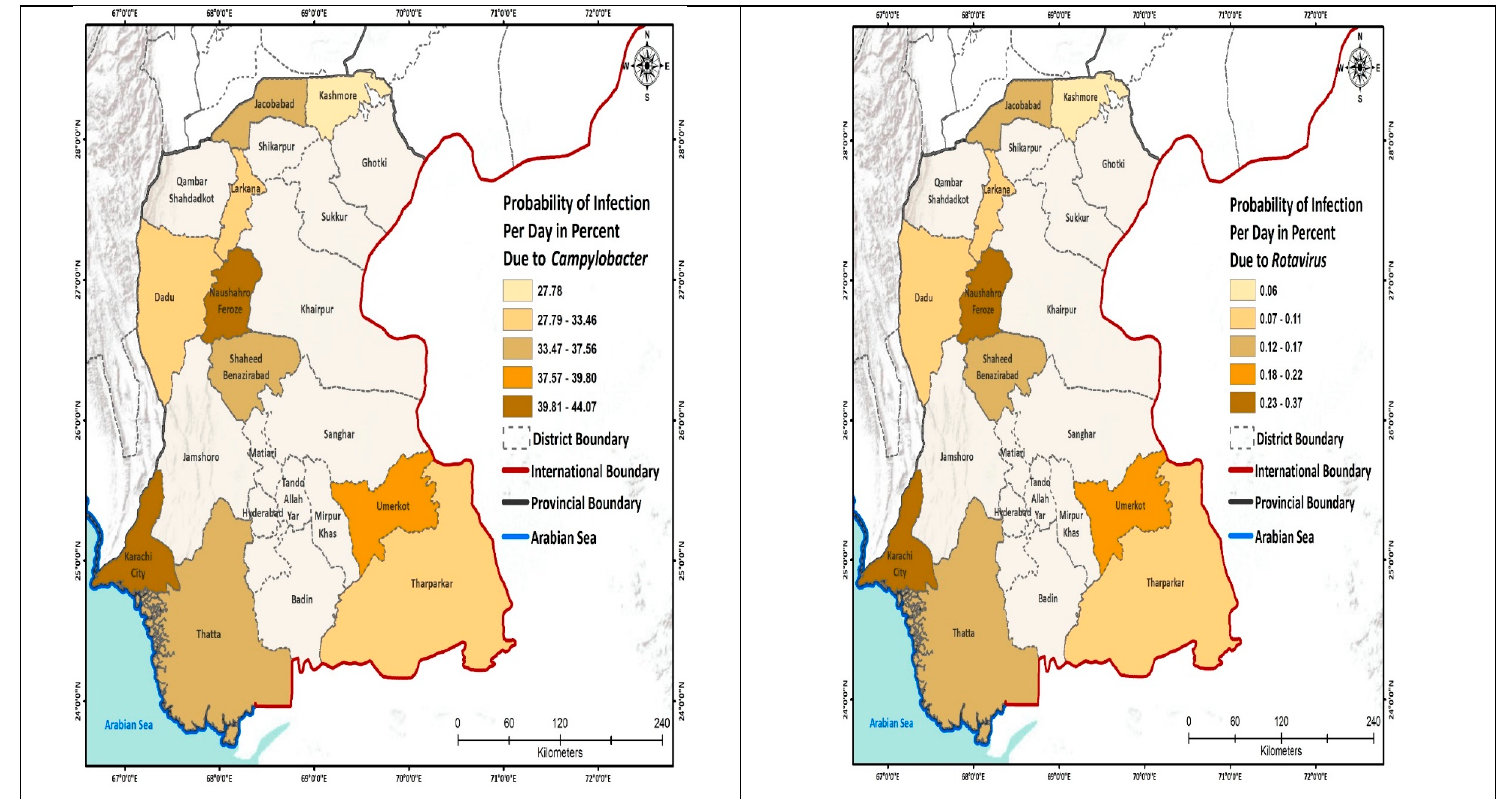
Figure 2. Probability of infection (P inf ) to the schoolchildren per day.